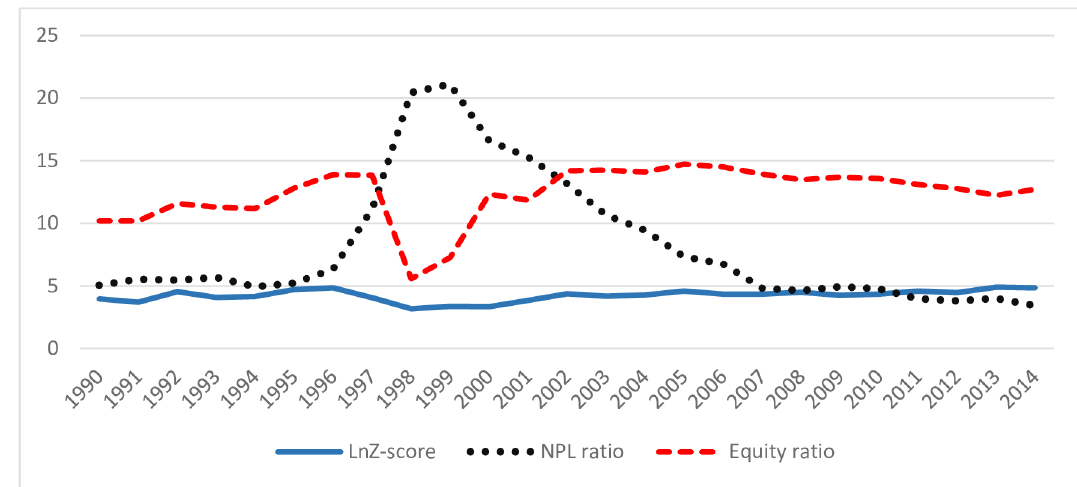
Fig 2. The relationship among lnZ-score, NPL ratio and Equity ratio in ASEAN-5 from 1990–2014 period. Note: Fig 2 presents the relationship amonglnZ-score, NPL ratio and equity ratio in ASEAN-5 from 1990 to 2014. ASEAN-5 includes Indonesia, Malaysia, the Philippines, Singaporeand Thailand.Definitionof lnZ-score, NPL ratio and equity ratio, and source of their data collectionare presented in S1